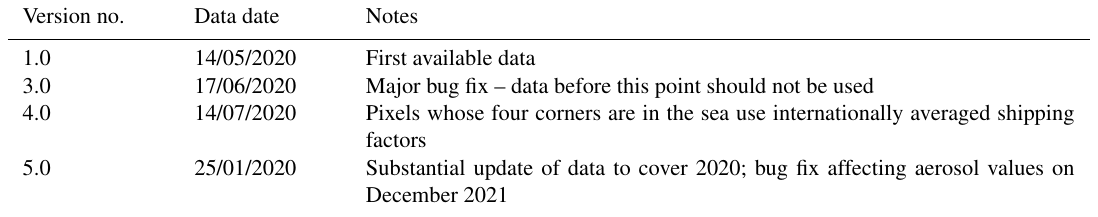
Table 1. Table of noteworthy difference between versions of data. The first digit of the version number is incremented by both additional months of complete data and by major coding developments. The second digit represents significant coding changes or additional data use within the same final month of data – these data are broadly inter-compatible. The third decimal place denotes changes in the times at which data are reported or minor bug fixes.